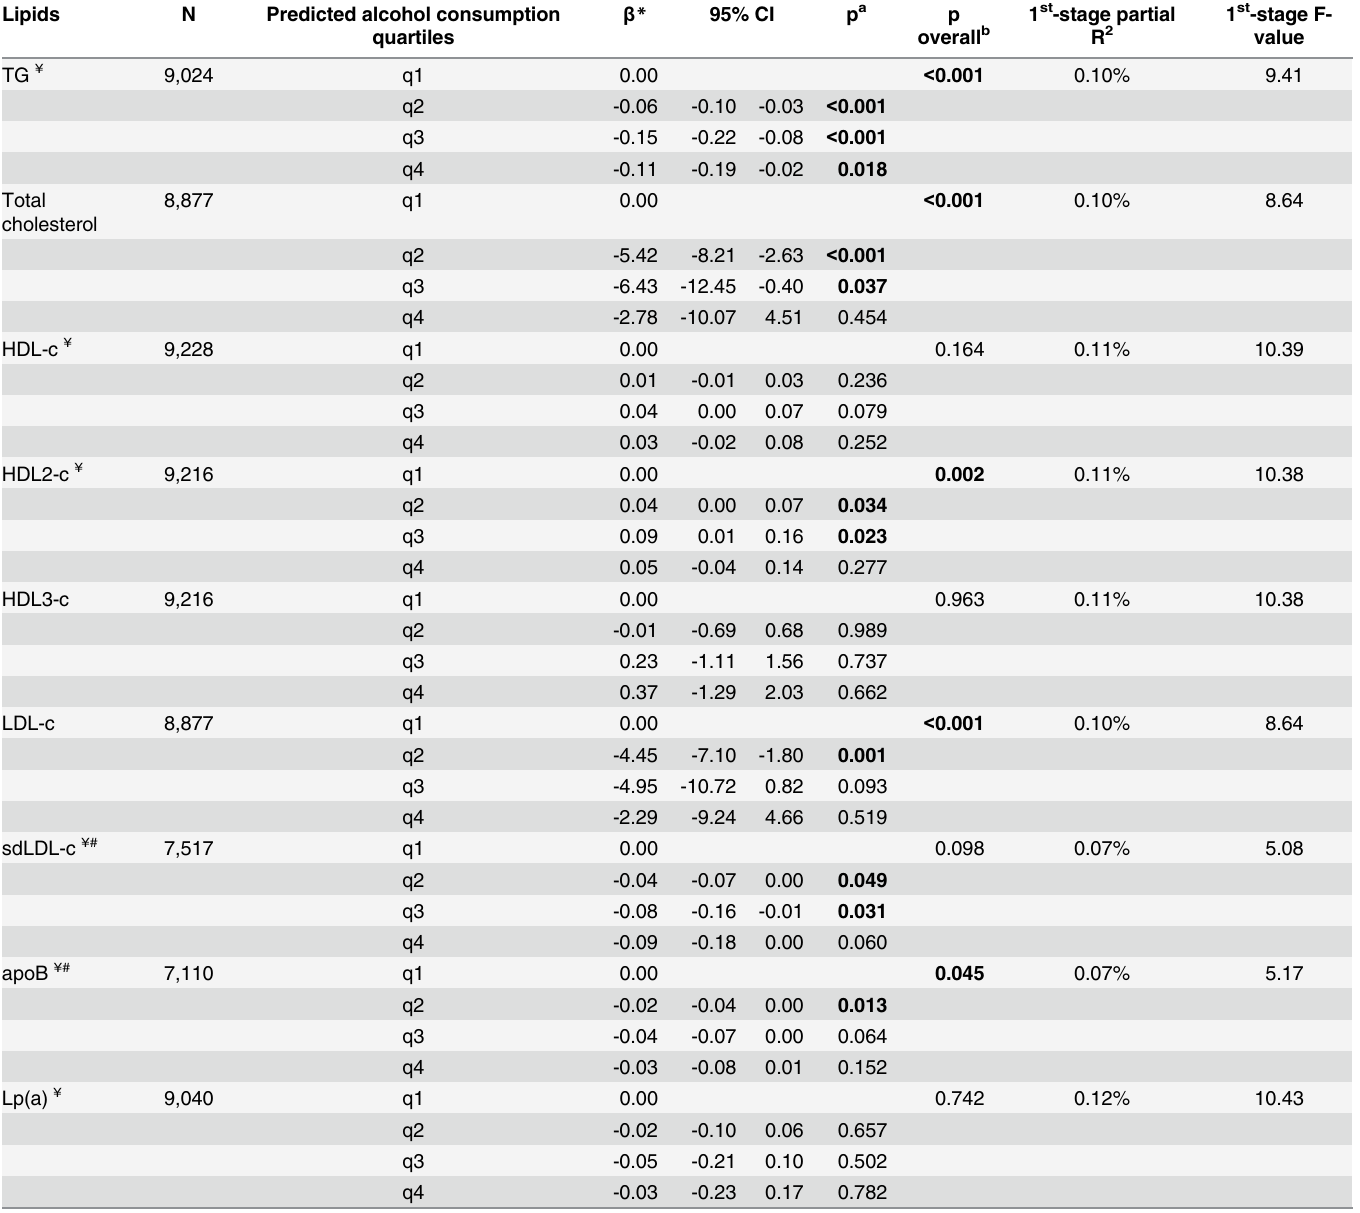
Table 5. Sensitivity IV analysis excluding heavy drinkers.